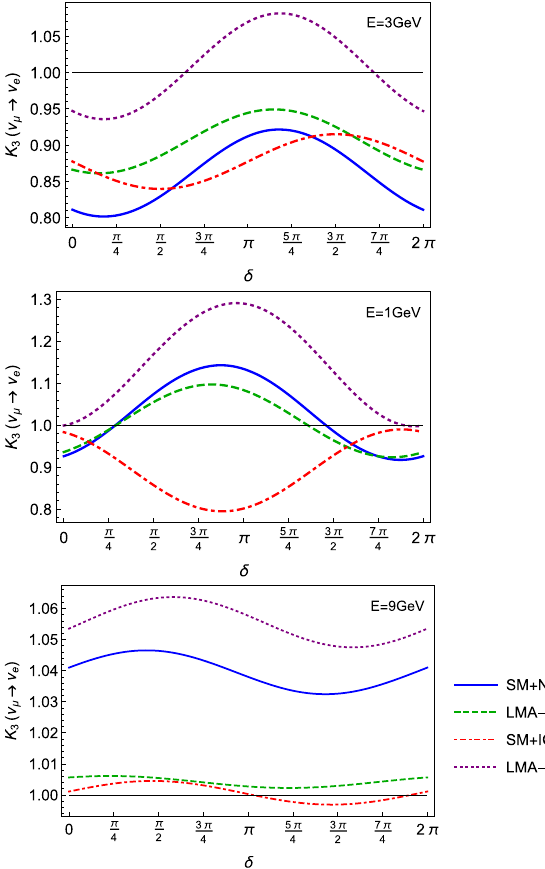
Fig. 2 Parameter K 3 is plotted with respect to δ (radian) at E = 1 GeV (upper), E = 3 GeV (middle) and E = 9 GeV (lower) for the case of SM-interaction with NO (blue solid curves), LMA-Light + NO (green dashed), SM + IO (red dot-dashed) and LMA-Dark + IO scenario (pur- ple dotted). These plots are obtained in the context of DUNE experi- mental setup (i.e., L = 1300